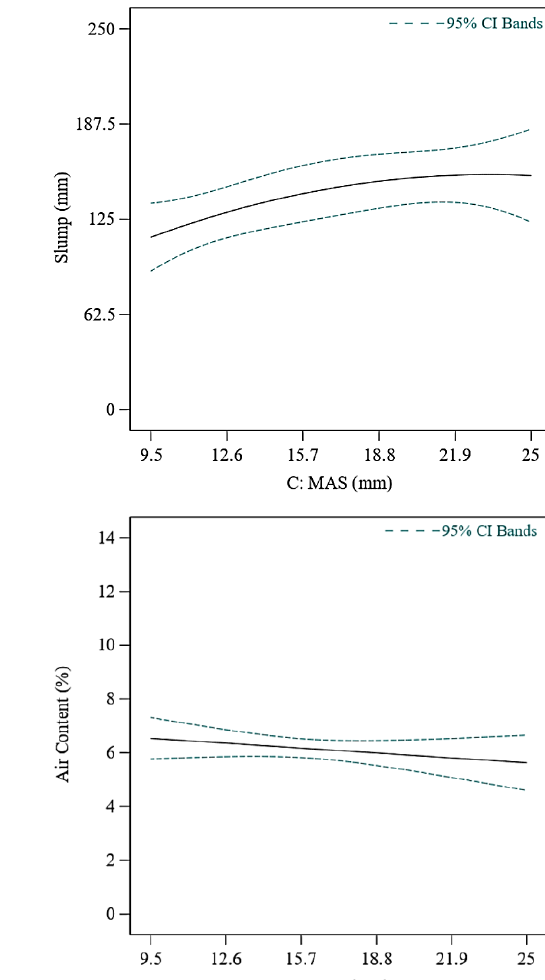
Figure 7. The fractured surface of GC26-mix with CAR = 45%.